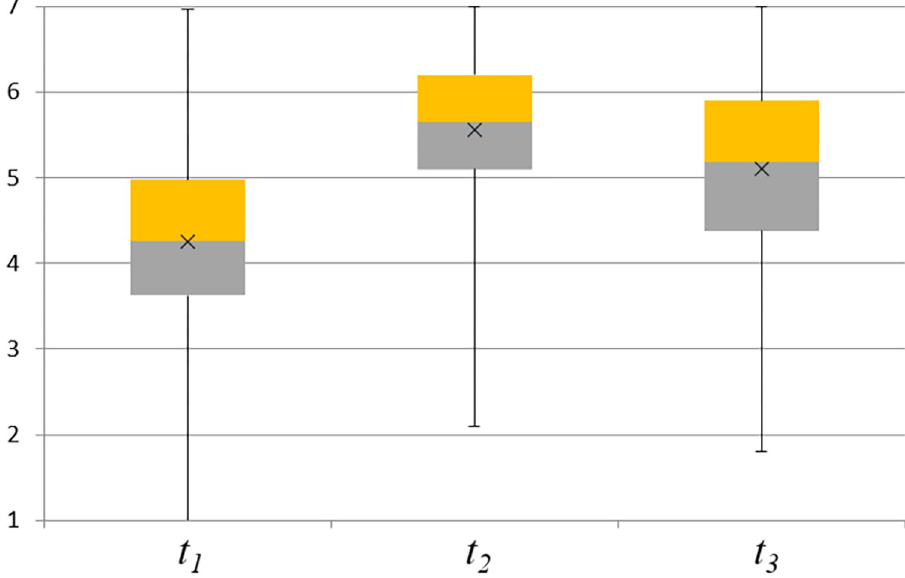
Fig 2. Boxplots of participants’ opinions (N = 366) at the measurement times t 1 , t 2 and t 3 . The top of the upper whisker and the bottom of the lower whisker represent the maximum and minimum values, the top and bottom of the box represent the 75 th and 25 th percentiles, the line through the box represents the median, and the x marker represents the mean of the sample.